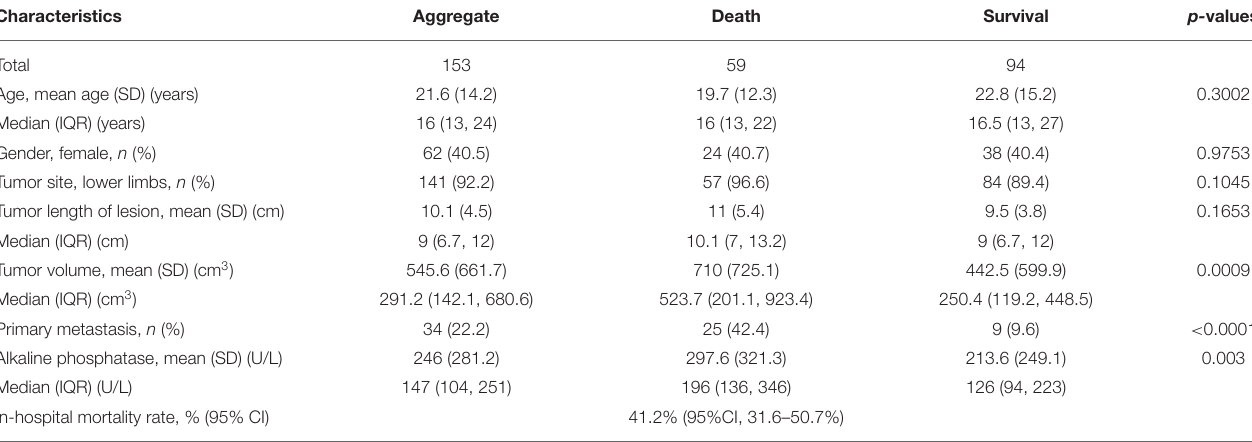
TABLE 1 | General characteristics of the 153 patients.